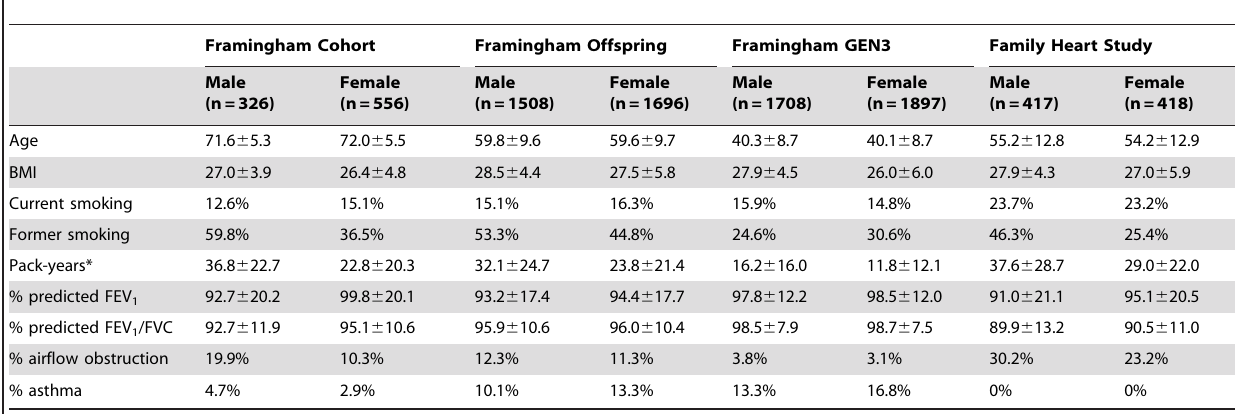
Table 1. Descriptive characteristics of the Framingham and Family Heart Study